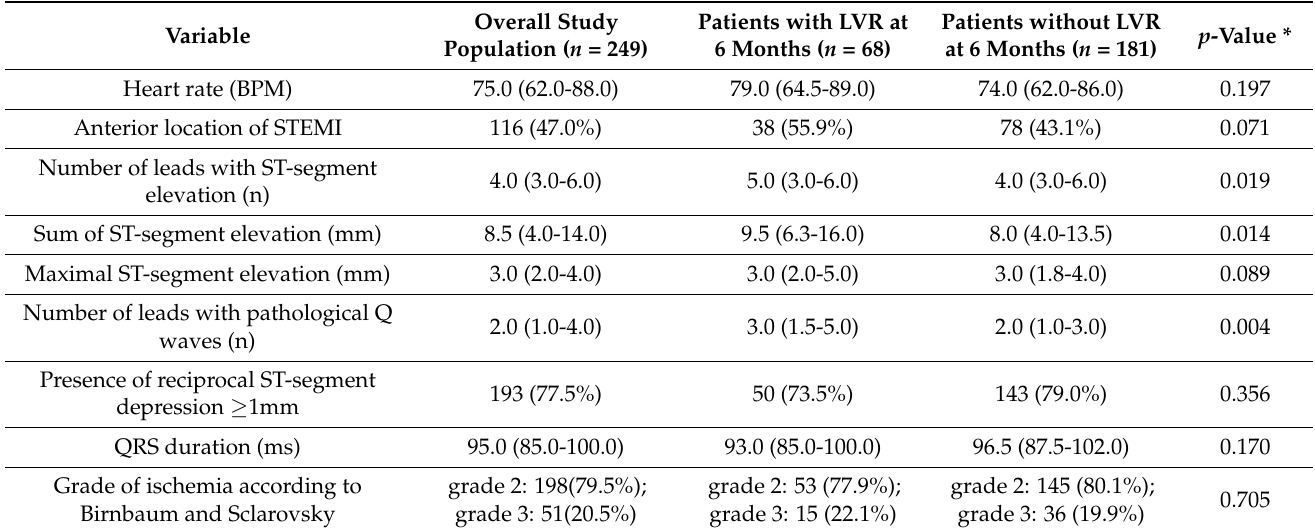
Table 3. Baseline electrocardiographic characteristics of the study population (median (lower quartile-upper quartile) or number